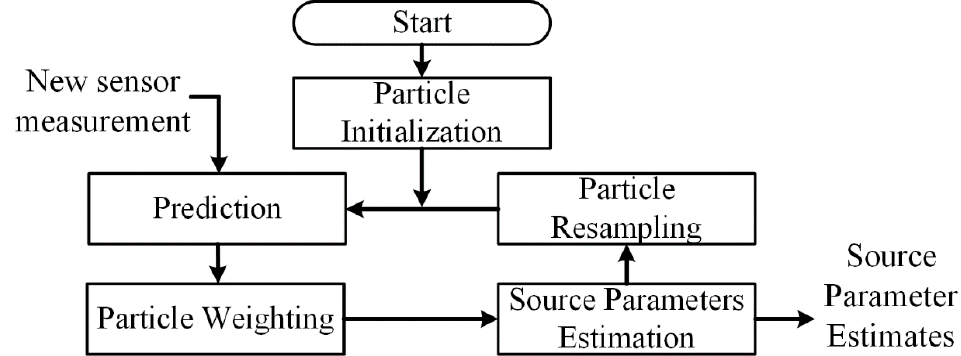
Figure 2. Flowchart of the traditional particle filter in sources localization application.